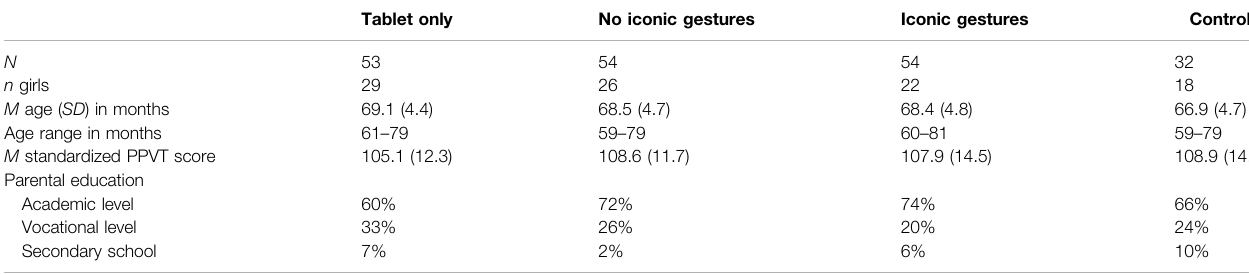
TABLE 1 | Background characteristics of the children in the four conditions.